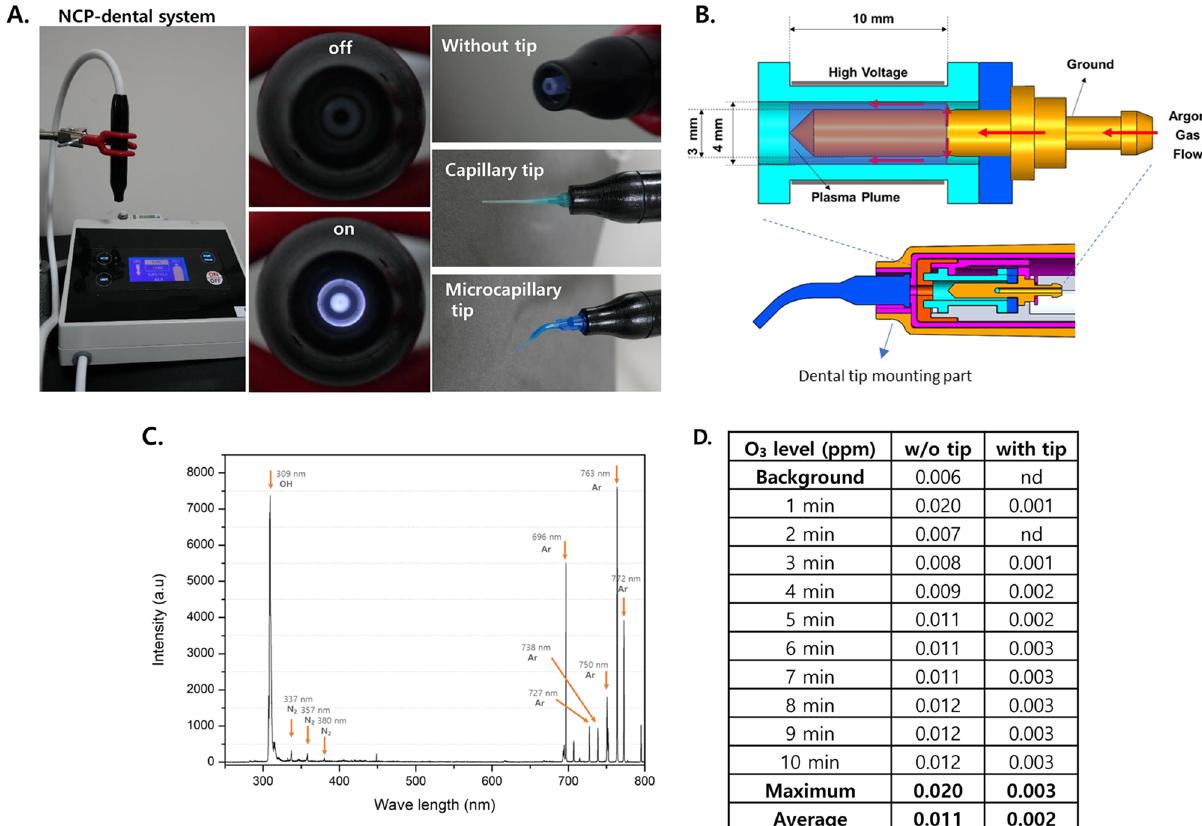
Figure 1. The NCP device can mount dental tips and produces argon plasma with low ozone. (A) The photographs of the NCP device developed and used in this study. This device can mount most of dental tips in the market. (B) A schematic diagram describing the structure of NCP generating part of the device. (C) The result of OES analysis of the plasma from the NCP device without dental tips. (D) The results of the measurement for the O 3 level from NCP device. The measurements was performed for 10 min, and the O 3 level was detected at every min. The distance between the gas inlet of O 3 detector and the end of the NCP outlet (regardless of with or without capillary tip) was maintained at 1